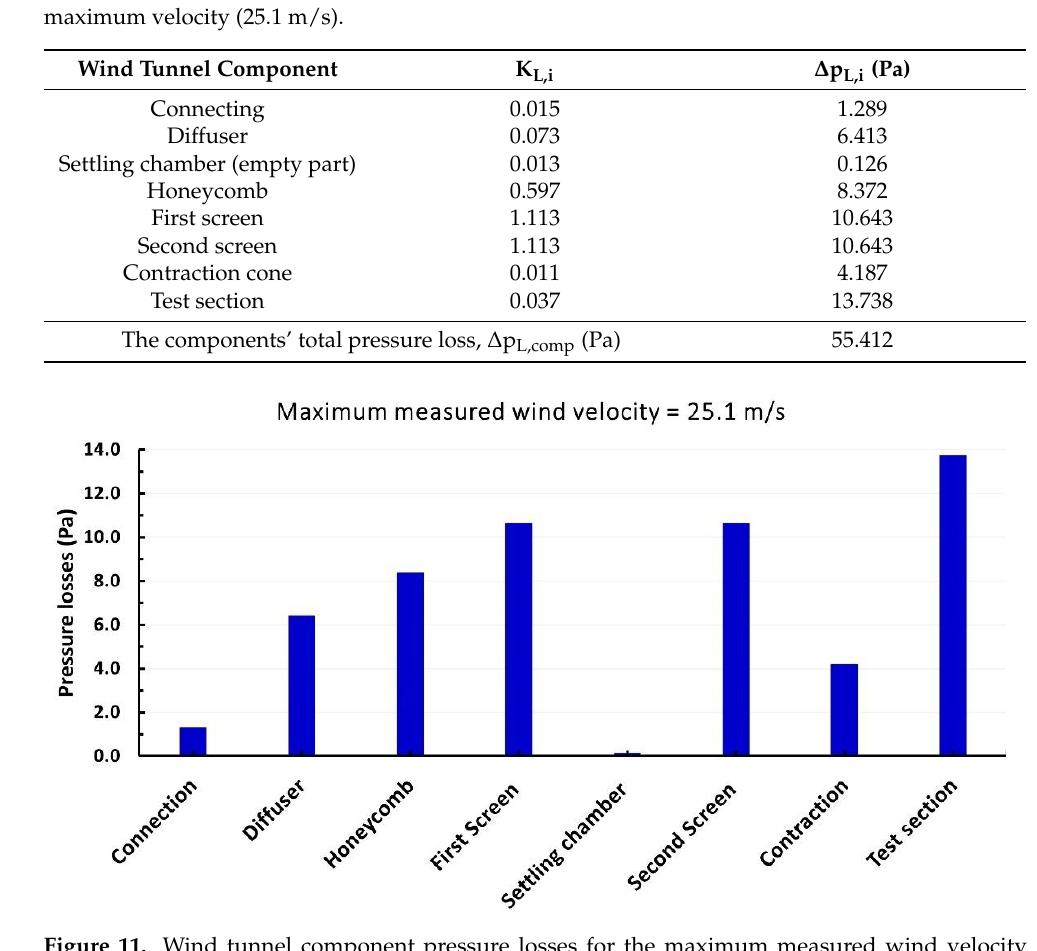
Figure 11. Wind tunnel component pressure losses for the maximum measured wind velocity (25.1 m/s). (25.1